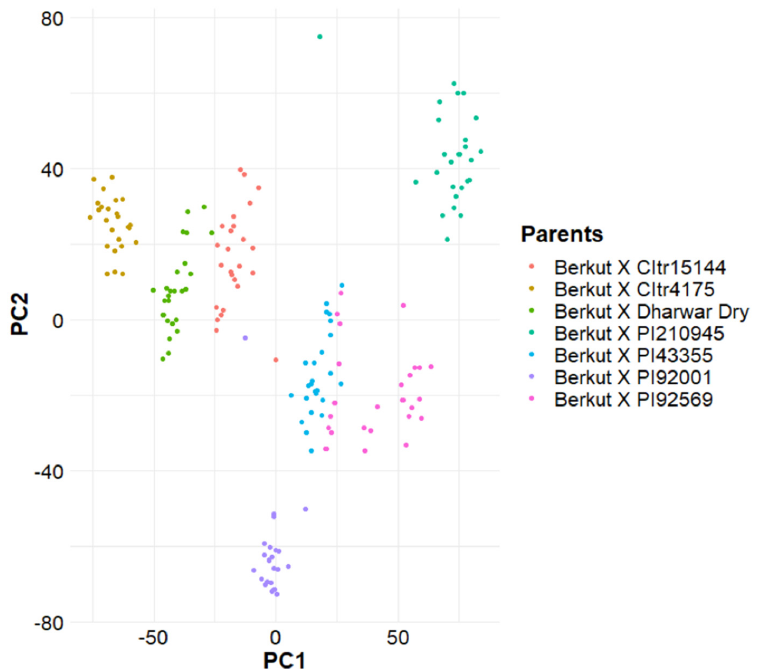
Figure 3. Population structure inferred from principal component analysis and illustrated with the first two principal components’ help. The whole population is subgrouped into seven groups, each group representing a single NAM family. Different colors in the figure represents the seven different NAM families evaluated in this study for grain protein content stability.